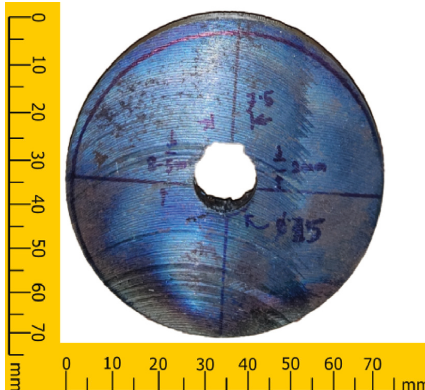
Figure 21: Substrate used for the embedded substrate